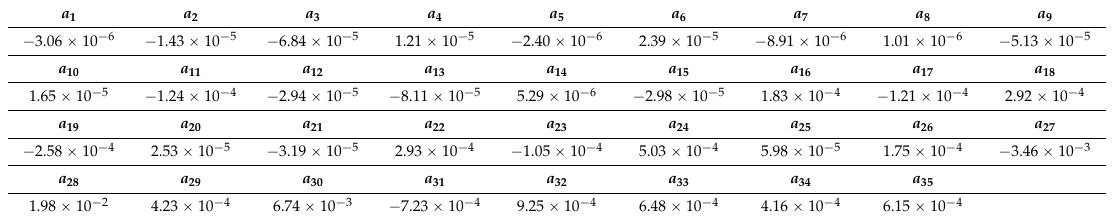
Table A2. Parameters of freeform surface 2.